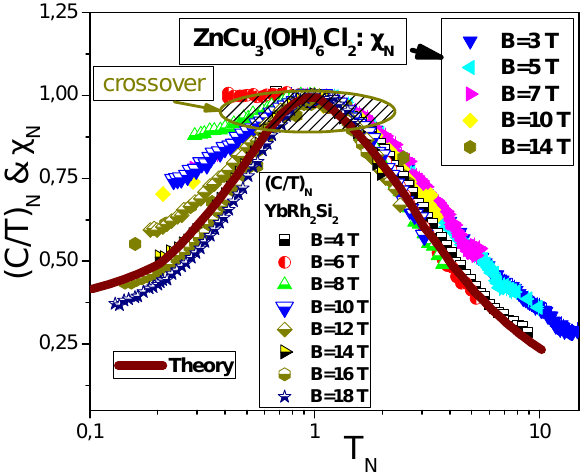
Figure 3. Normalized magnetic susceptibility χ N = χ / χ max = M ∗ as a function of the normalized N temperature T N ∝ T / B . The values of magnetic field B are displayed in the legend. The data are extracted from the measurements of the magnetic susceptibility χ ( T , B ) on ZnCu 3 ( OH ) 6 Cl 2 [16]. FIG. 4: Normalized magnetic susceptibility χ N = χ/χ max = The normalized data of ( C el / T ) N = M ∗ are obtained from the specific heat measurements C el / T of M ∗ as a function of the normalized temperature T N T/B . N N ∝ YbRh 2 Si 2 in the presence of magnetic field B (the legend) [52]. The solid curve represents theoretical The values of magnetic field B are displayed in the legend. calculations at B 18 T at the fully polarized quasiparticle band. It demonstrates universal scaling of (cid:39) M ∗ , and coincides with the universal scaling of the quantum spin liquid depicted in Figure 1. The N crossover from the LFL behavior to the NFL one is displayed by the arrow.